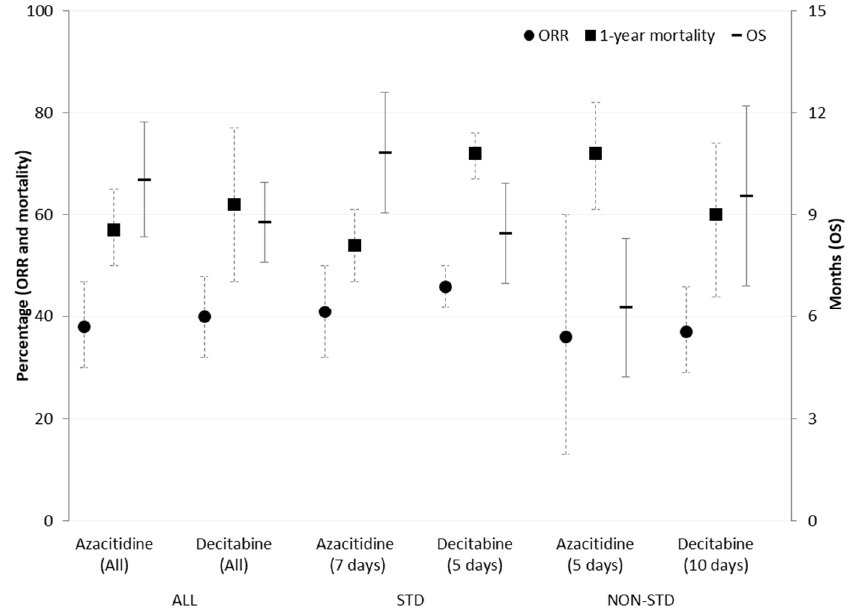
Figure 5. Summary of results. Abbreviation: ORR, overall response rate; OS, overall survival; STD, standard; Non-std, non-standard.